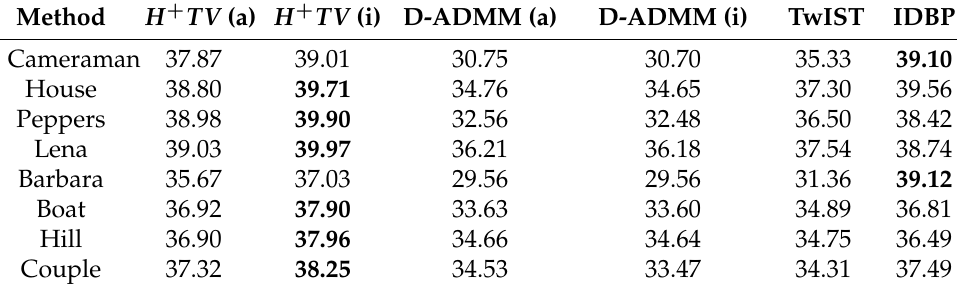
Table 1. Comparison of PSNR values of each method in eight